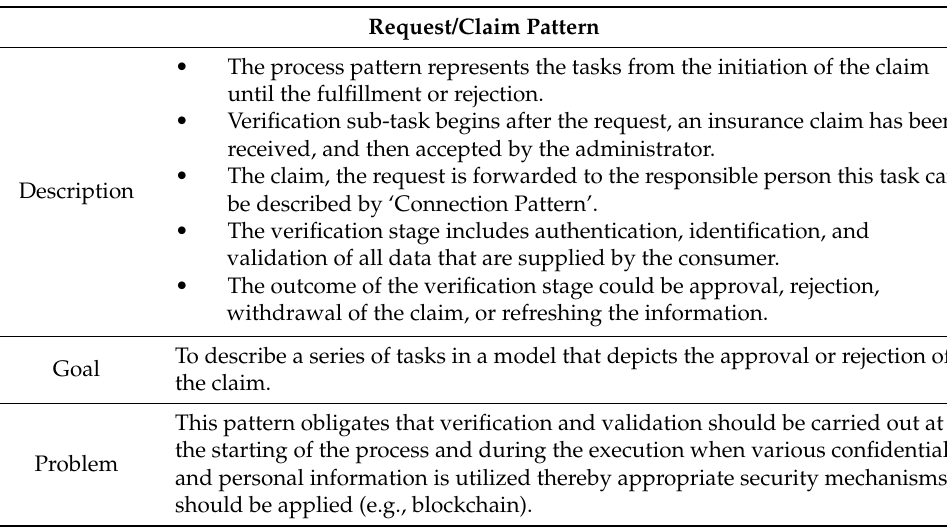
Table 1. Business Process Pattern: Claim.